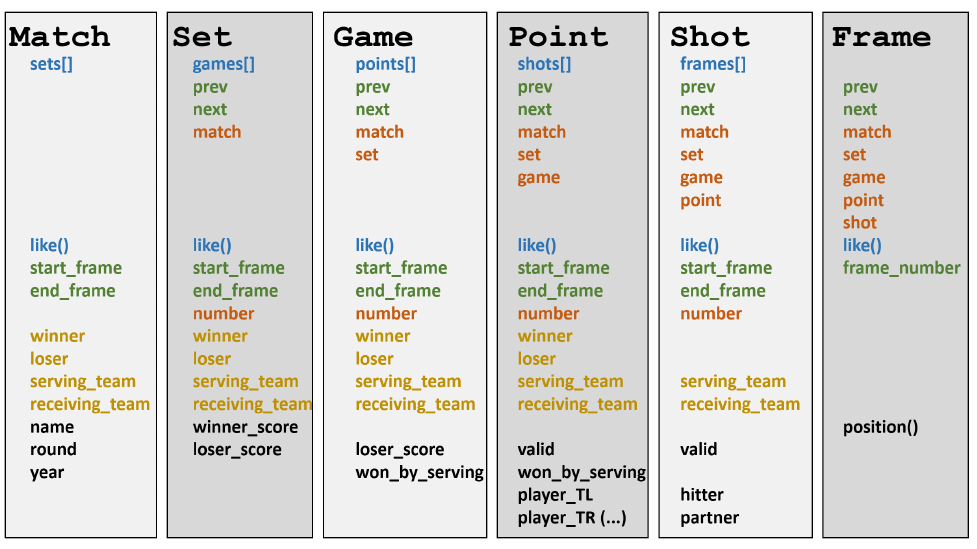
Figure 9. Main classes and methods in our API. Colors indicate coherent methods across